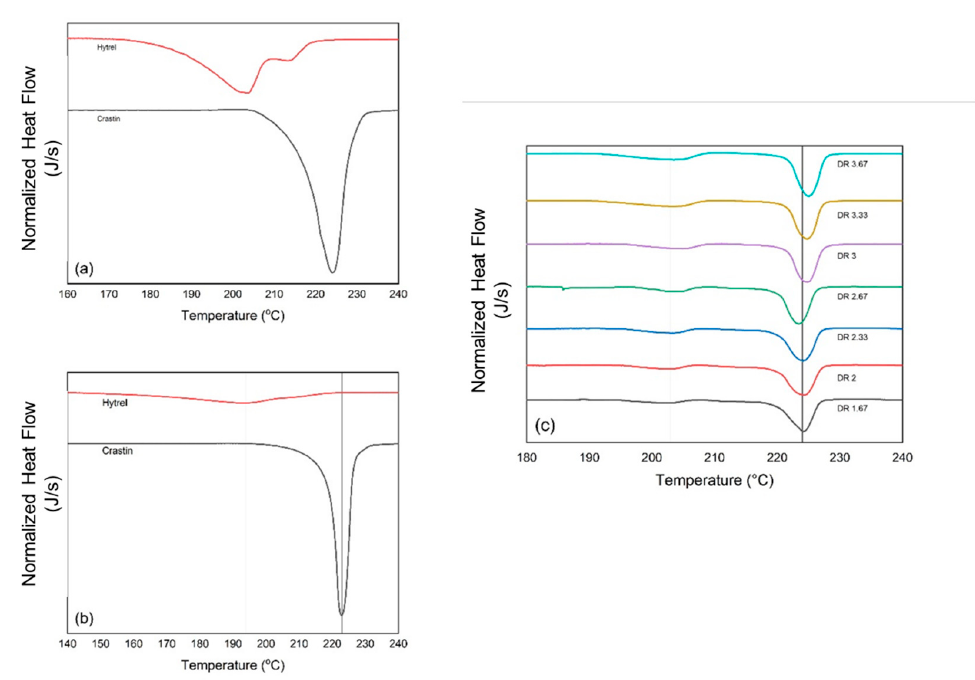
Figure 3. DSC curves for ( a ) Hytrel and Crastin pellets, ( b ) Hytrel and Crastin monofilament fibers, and ( c ) Bi-component fibers with respective draw ratios (DR).